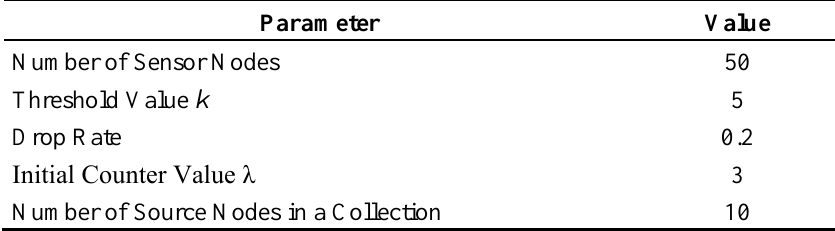
Table 1. The major parameters for the